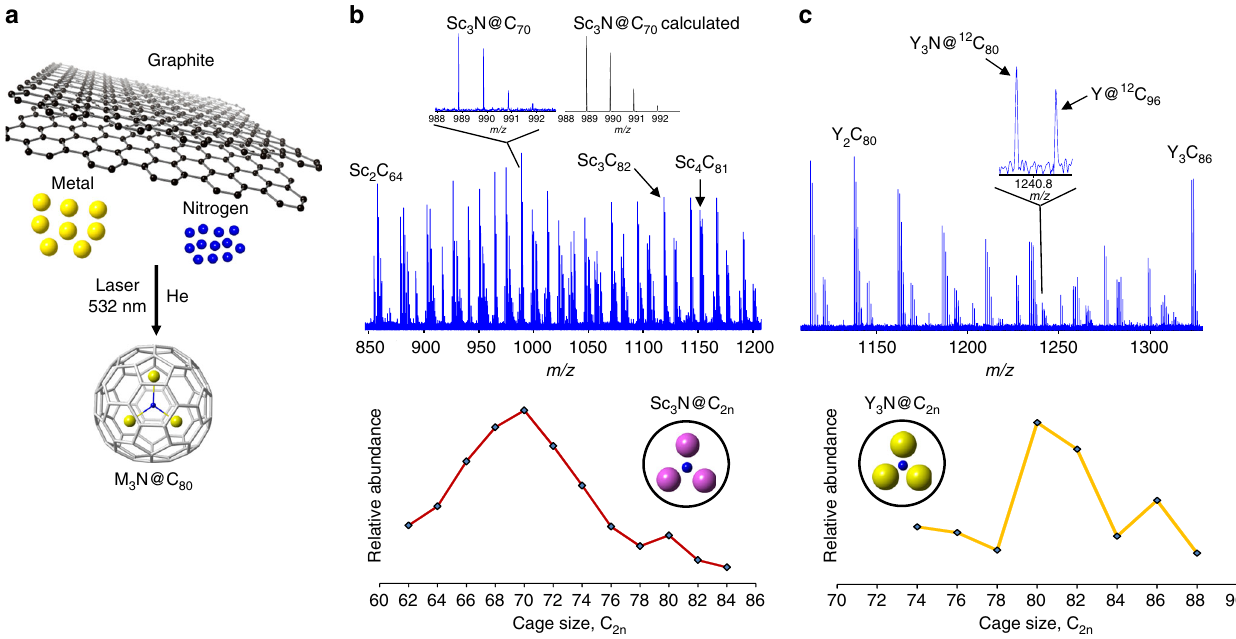
Fig. 1 Clusterfullerenes formed by laser vaporization of group 3 metal-doped and nitrogen-doped graphite. a Synthesis schematic for clusterfullerenes formed from a mixture of graphite, metal oxide, and melamine (nitrogen source) in this work. FT-ICR mass spectra of cluster cations generated by laser vaporization of b Sc-doped and N-doped graphite and c Y-doped and N-doped graphite. M 3 N@C 2n formation distributions are graphically shown below each